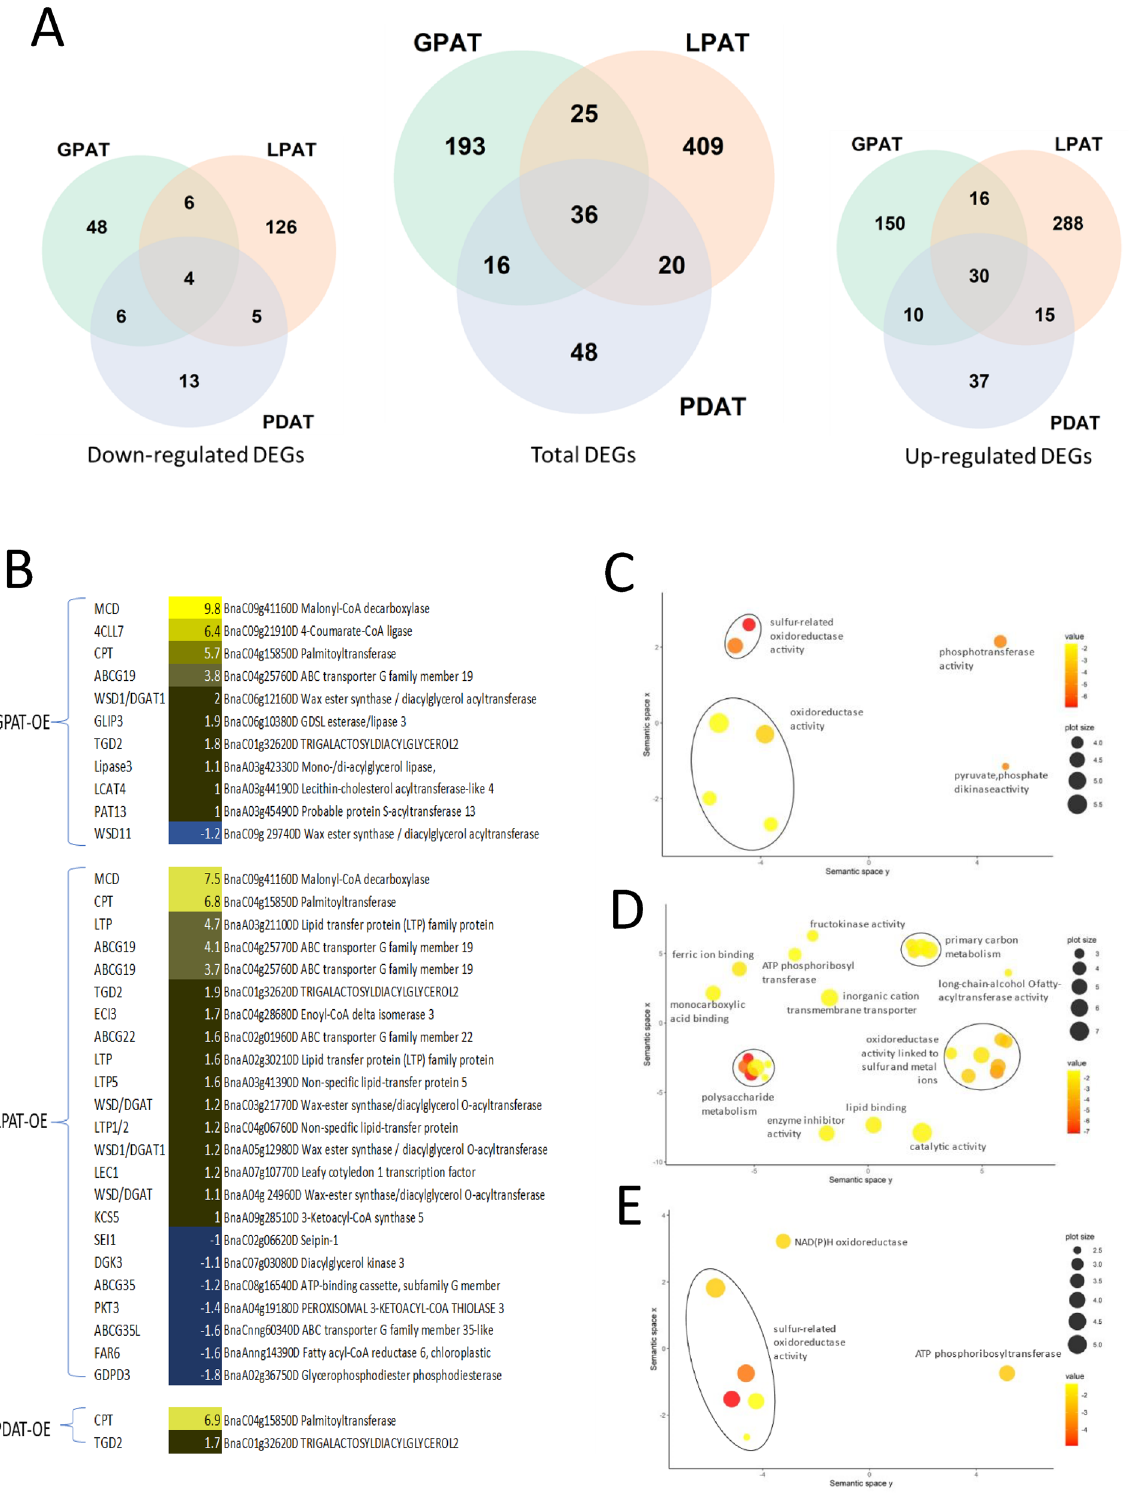
Figure 4. Transcriptomic analysis of GPAT9-OE, LPAT-OE and PDAT-OE transgenic lines. ( A ) Total number of differentially expressed genes (DEGs) identified in comparisons of GPAT9, PDAT or LPAT overexpressing lines compared to WT control. ( B ) Heat-map of selected DEGs related to lipid metabolism. ( C – E ) GO enrichment analysis for molecular function in the GPAT-OE ( C ), LPAT-OE ( D ) and PDAT-OE ( E )